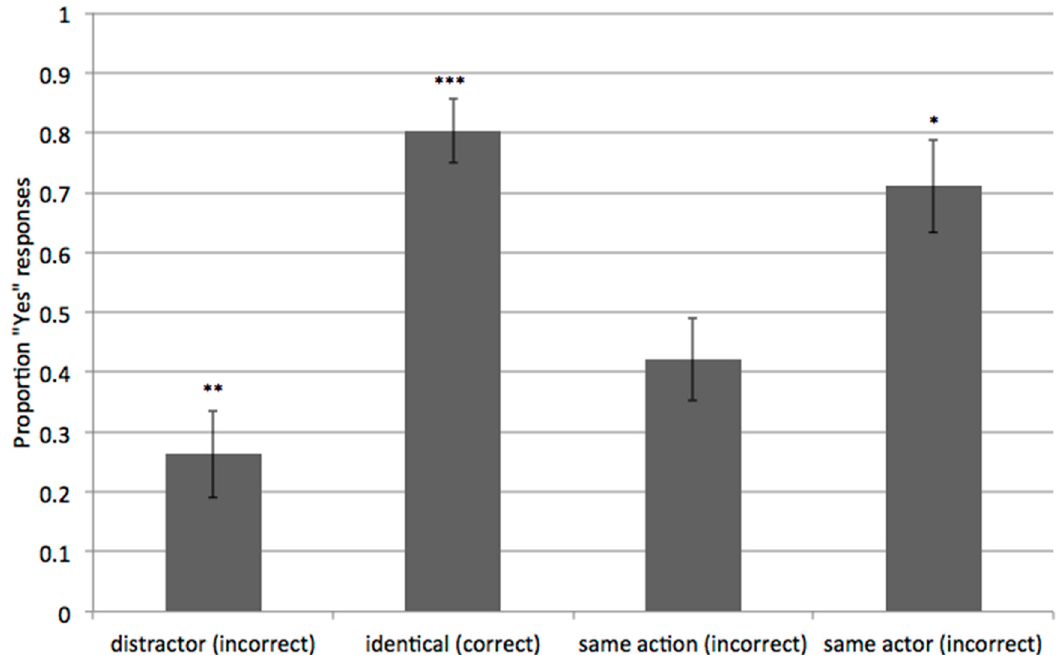
Figure 3. The proportion of “Yes” responses to the identical, same-action, same-actor and distractor test videos. Whether or not a “Yes” response would be correct is indicated in brackets. The error bars indicate the standard error of the means. Whether the mean is significantly different to chance (0.05) is shown by *** indicating p < 0.001, ** indicating p < 0.01 and * indicating p < 0.05.